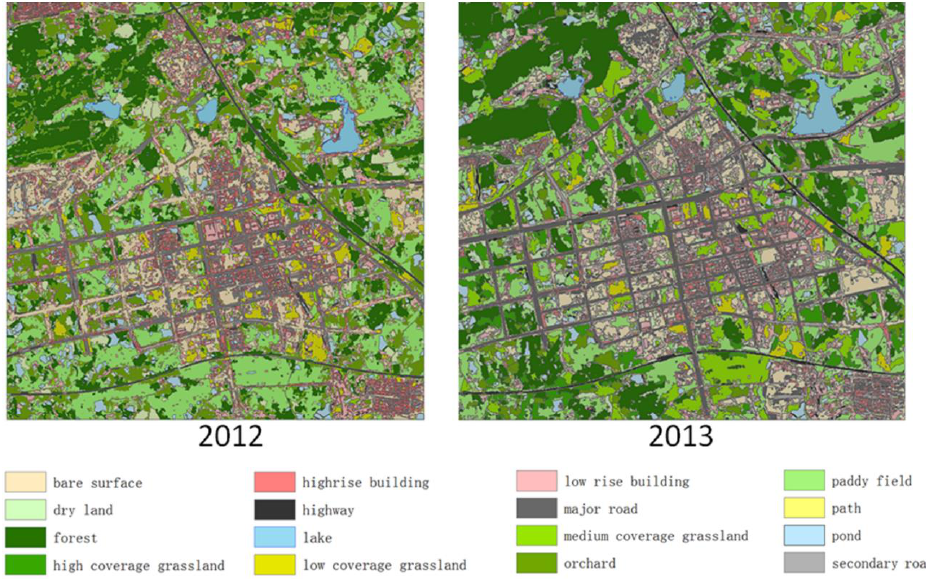
Figure 7. Classification result of the study area. Left is the extraction result for study area in 2012. Right is the result in 2013. It can be seen from the results that certain areas of bare surface become roads or buildings in